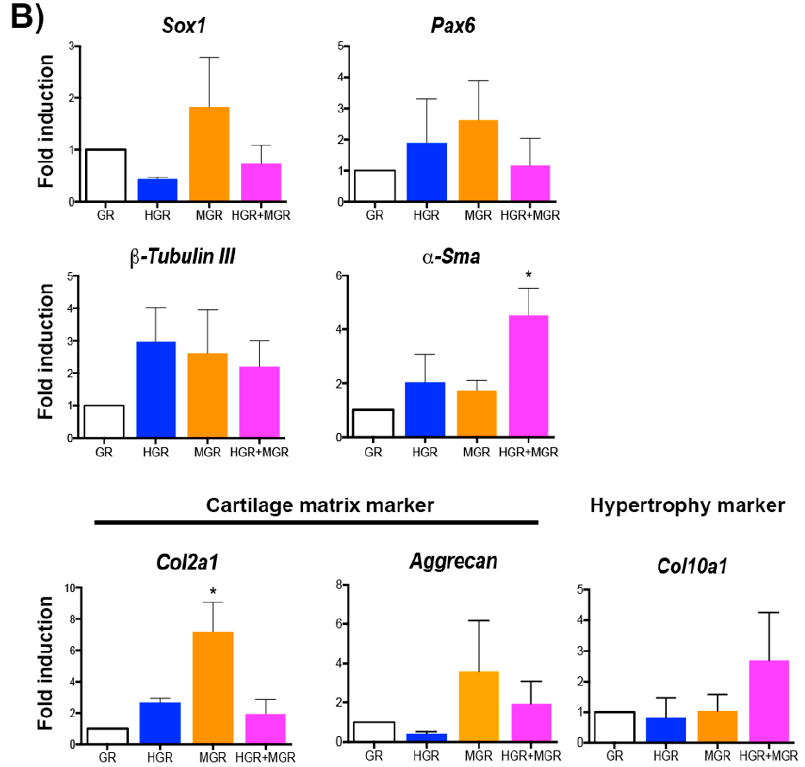
Figure 7. Activation of nuclear translocation of chimeric proteins during differentiation of mESCs into NC derivatives increased the Col2a1 transcripts in MGR cells and α - Sma transcripts in double transgenic cells. Transgenic mESCs were differentiated into neural crest derivatives and stimulated with 10 µ M Dex to promote nuclear translocation of the transgenic proteins from day 1. Analyses were conducted at day 10 of differentiation. ( A ) End point RT-PCR showed significant increases in Sox10 expression in MGR and HGR+MGR cells relative to GR and HGR cells after stimulation of nuclear translocation. Please note that the primers for Hes1 and Msx1 detect the endogenous forms and not the transgenes ( B ) Quantification of the neural and neural crest differentiation markers via RT followed by qPCR. The fold induction was relative to the levels in GR cells. The data for each transcript were normalized to β -actin levels. mean ± SEM. Statistical analysis of all conditions was conducted via ANOVA followed by Tukey’s multiple comparison test from 3–4 independent experiments. The marked significant differences are relative to GR, unless indicated otherwise. * p < 0.05.